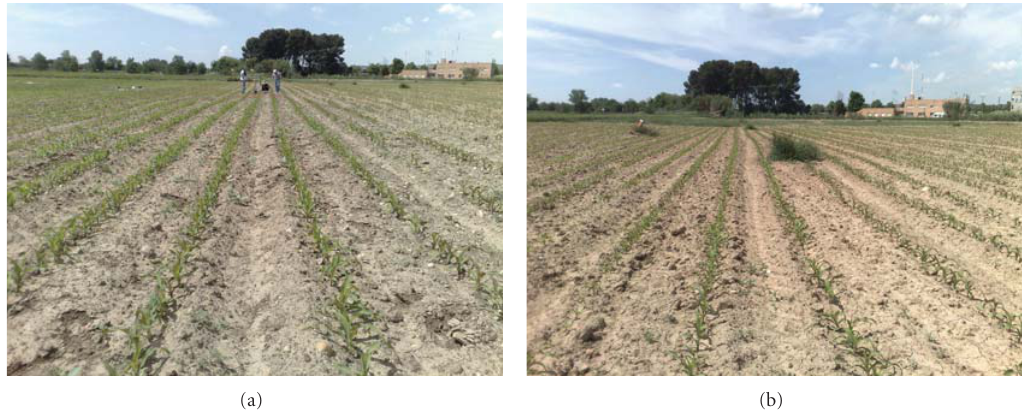
Figure 1: Di ff erent brightness due to di ff erent weather conditions: (a) darker; (b) clearer.